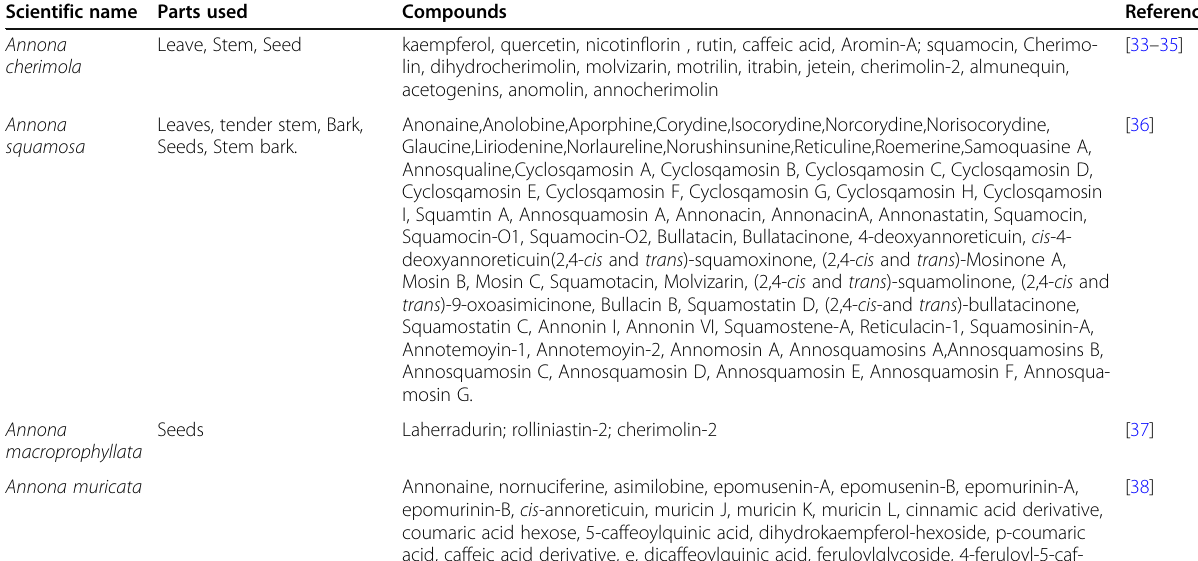
Table 2 Phytochemical constituents of the species Scientific name Parts